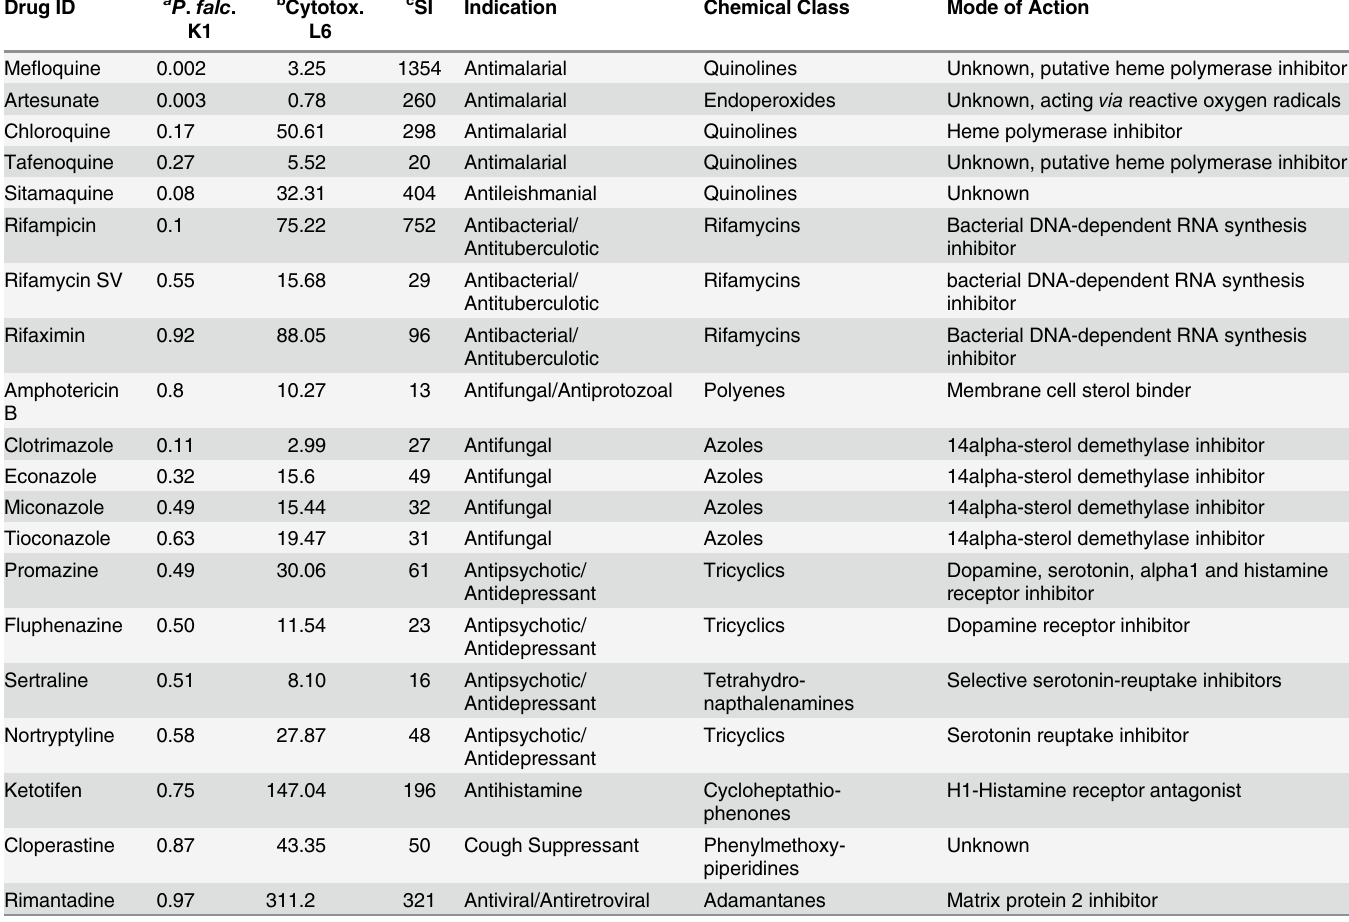
Table 4. In vitro activity against P . falciparum in IC 50 ( μ M) of compounds fulfilling hit criteria. Drug